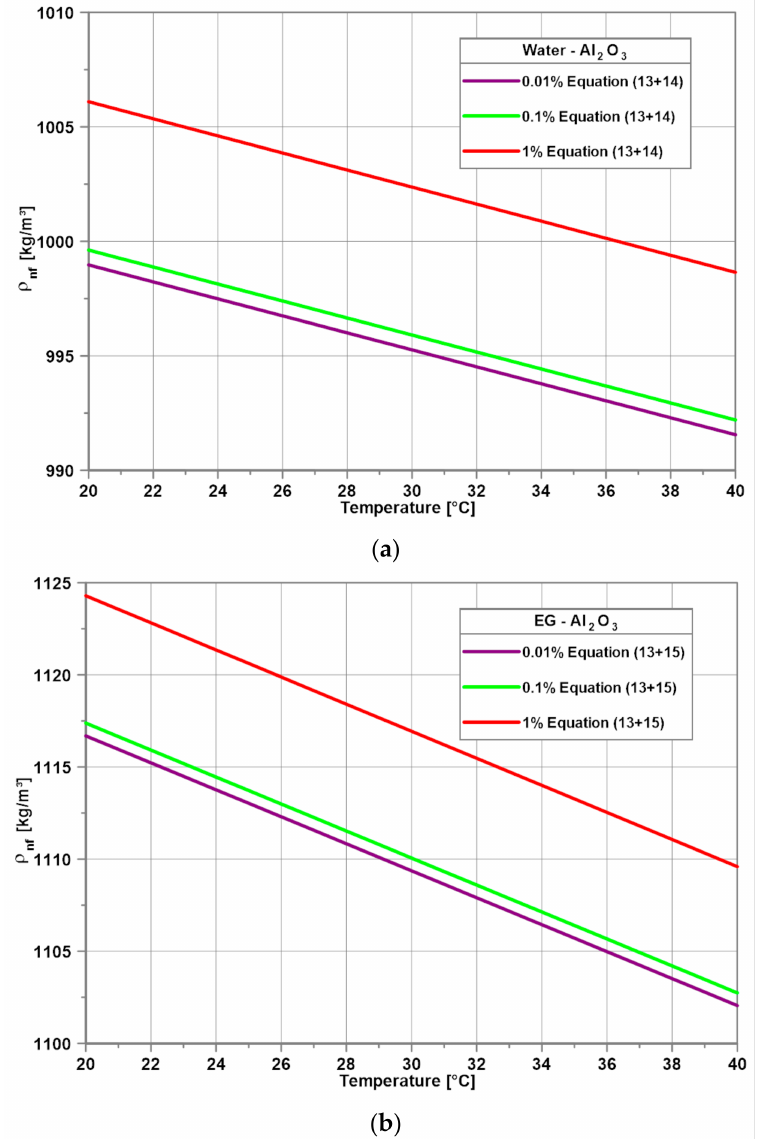
Figure 3. Density of the water-based ( a ) and EG-based ( b )